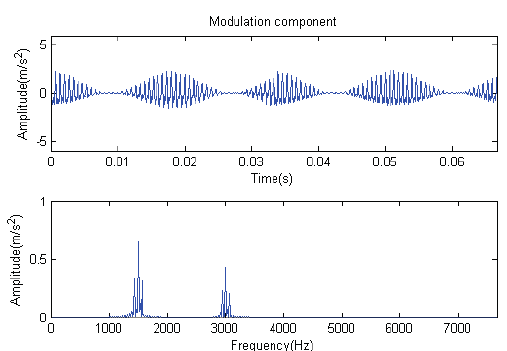
Figure 34. Modulation